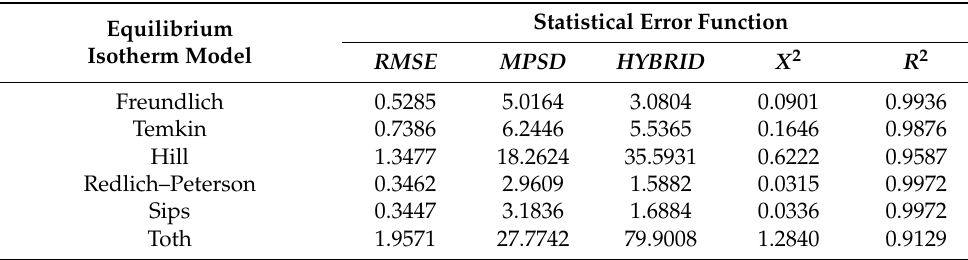
Table 11. Statistical error functions of estimated equilibrium isotherm nonlinear models for the biosorption process conducted on SPRBA 5%